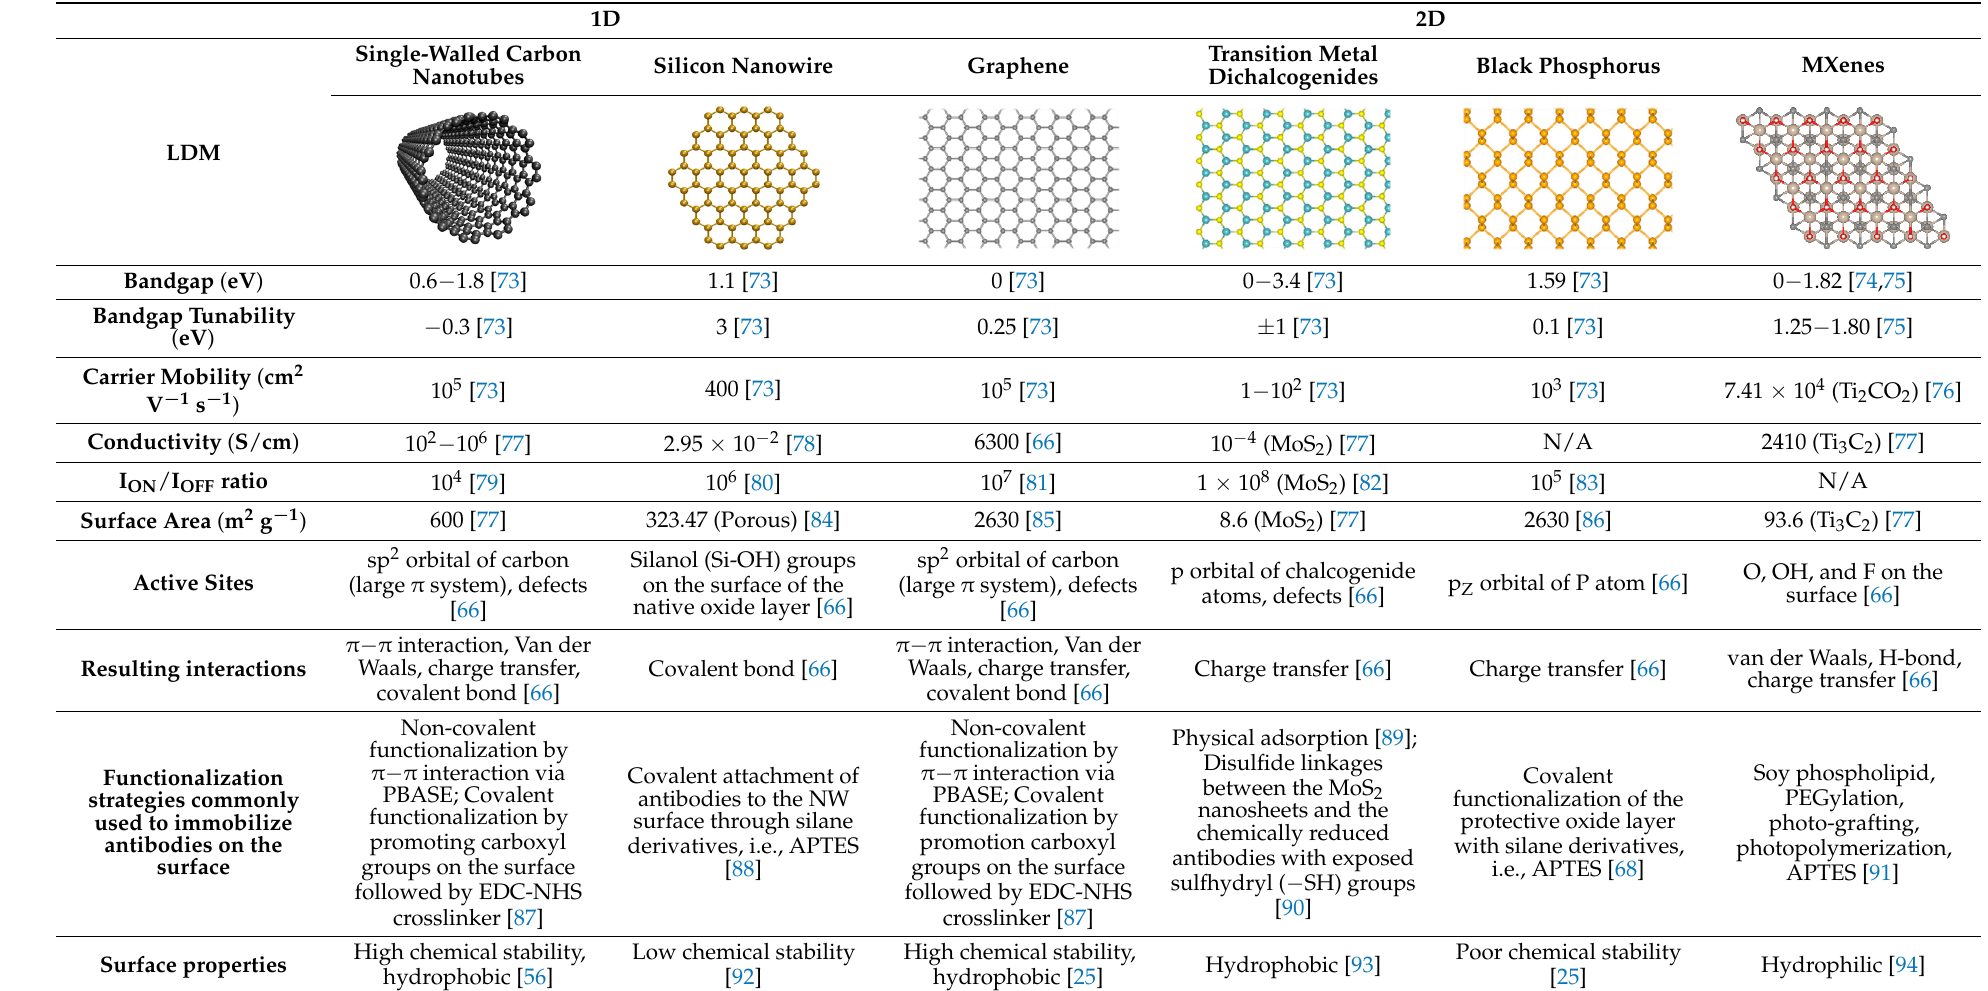
Table 1. Main properties and features of the most used LMDs in FET-based immunosensors.